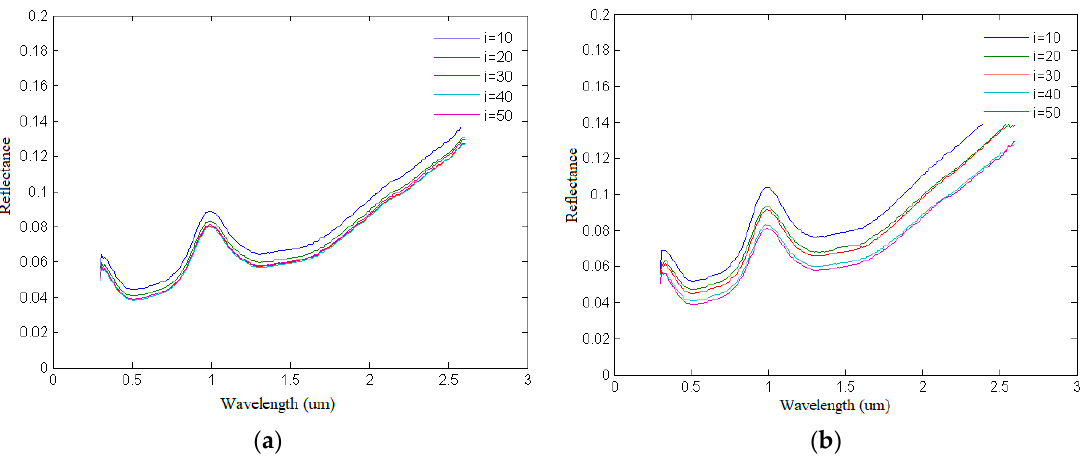
Figure 18. Comparison of the simulated ( a ) and measured spectra ( b ) of ilmenite when the Legendre polynomial coefficients of the phase function are set to − 0.4 and 0.25.